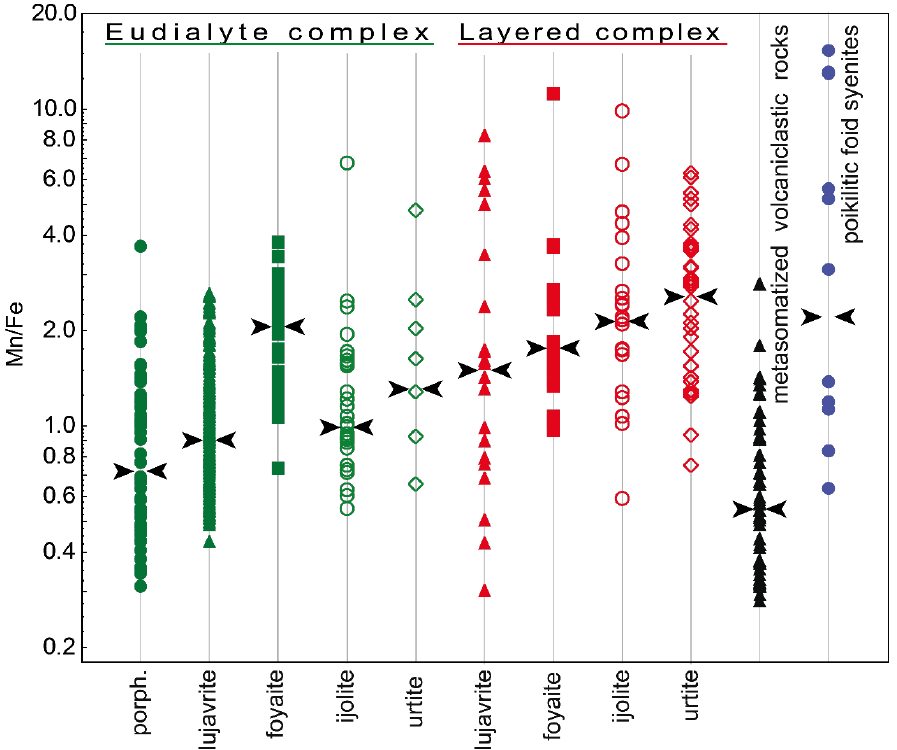
Figure 7. The Mn / Fe ratio in the EGM from rocks of the Lovozero massif. Black arrows show the Figure 7. The Mn/Fe ratio in the EGM from rocks of the Lovozero massif. Black arrows show the median contents. porph.—porphyritic / fine-grained nepheline median contents. porph.—porphyritic/fine-grained nepheline syenites.